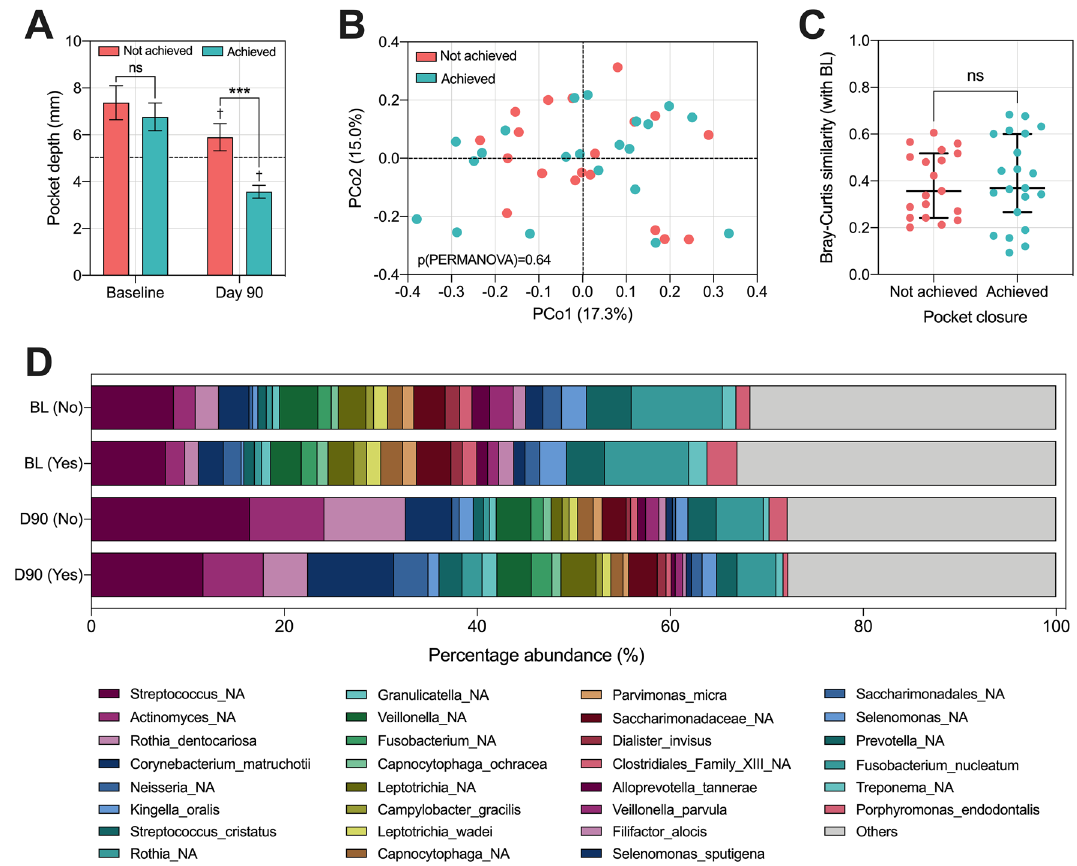
Figure 6. Investigating the subgingival plaque microbiome in relation to treatment response. ( A ) Comparing the pocket depth of sampled sites at baseline (BL) and day 90 (D90) depending on whether pocket closure was achieved (n = 21) or not achieved (n = 19) post-treatment. Dotted black line indicates 5 mm. Between group comparisons refer to unpaired t-tests (ns: non-significant, *** p < 0.001), within-group comparisons refer to paired t-tests († p < 0.001), graphs display mean ± 95% confidence interval. ( B ) Species-level Bray–Curtis based PCoA analysis of each group at baseline, statistics are PERMANOVA with raw p-value displayed. ( C